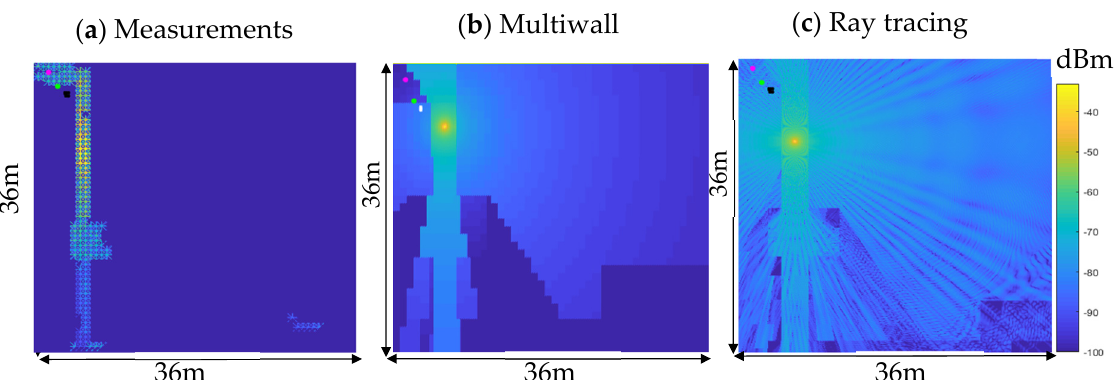
Figure 11. Reference RSSI distribution maps; ( a ) Dataset obtained from real measurement campaign, ( b ) Dataset prepared using multiwall model (using WHIPP software); ( c ) Dataset prepared using Ray Tracing model (using InSite software).